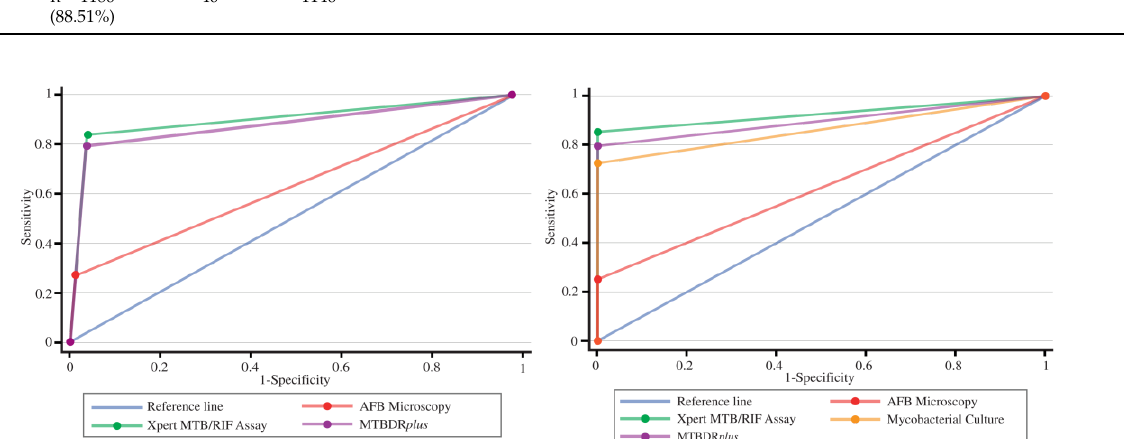
Figure 2. ROC curve analysis for the four TB diagnostic methods. ( A ) The AUC for AFB microscopy, Xpert MTB/RIF, and MTBDRplus when compared with the culture method. ( B ) The AUC for culture, AFB microscopy, Xpert MTB/RIF, and MTBDRplus when compared with CRS.